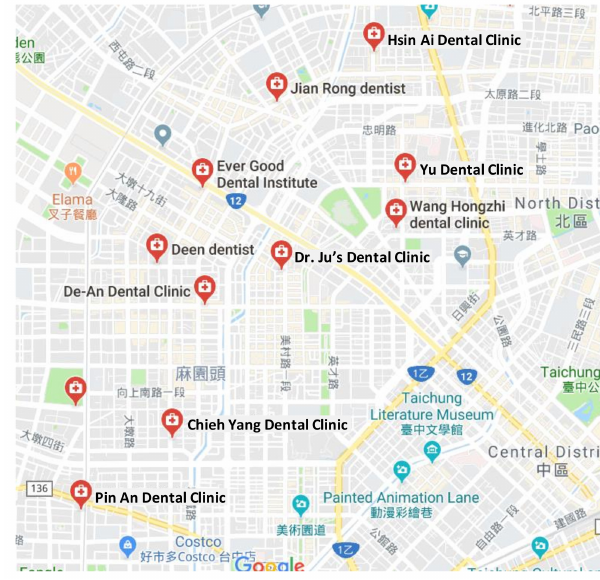
Figure 5. The experimental region. Table 8. The details of the first order.